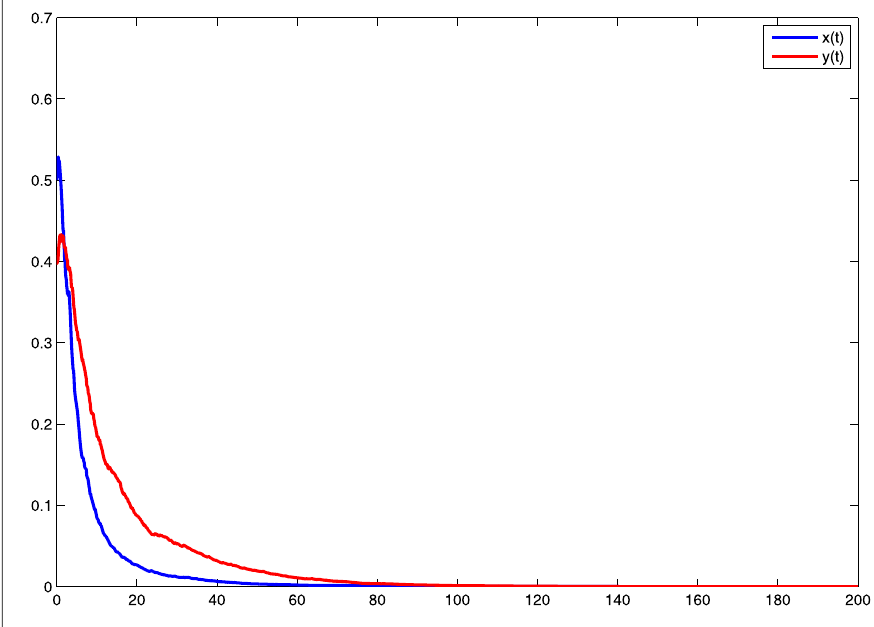
Figure 1 Solutions of model (3) with r 1 = 0.6, r 2 = 0.4, r 10 = 0.3, r 20 = 0.2, ξ 2 1 = 1.43, ξ 2 2 = 0.63, a = 0.4, c = 0.36, f = 0.25, h = 1. With α 1 = 0.55, α 2 =